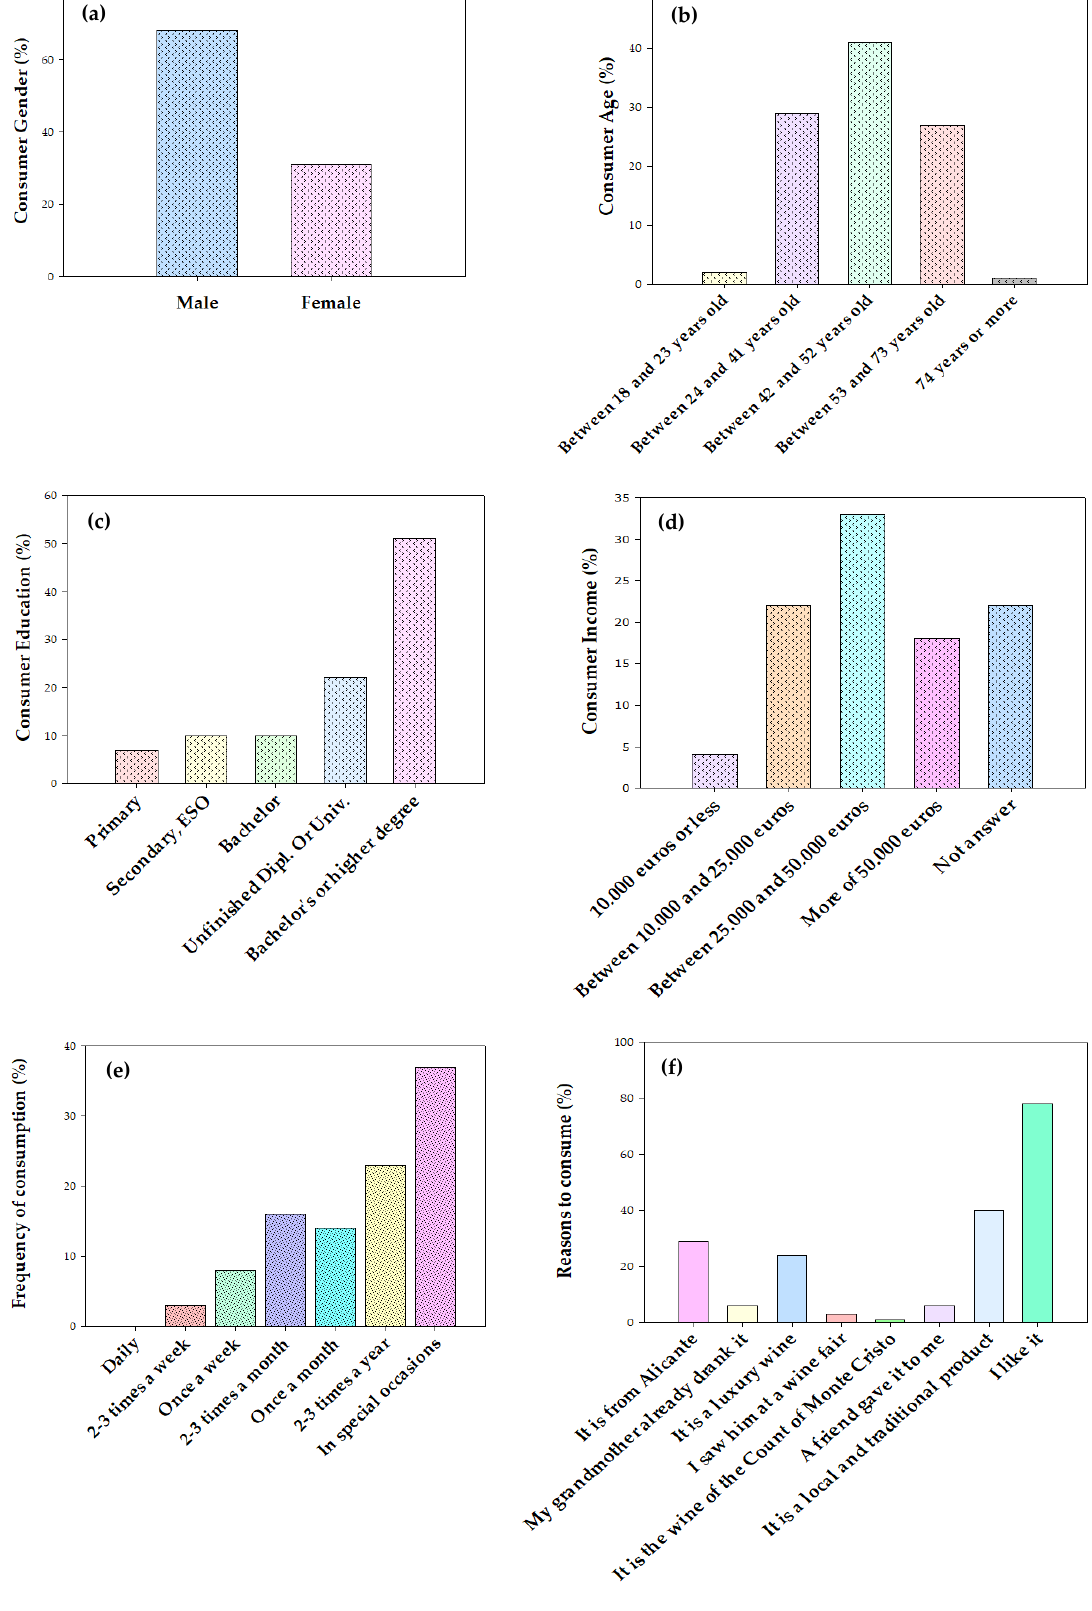
Figure 3. Fondill ó n consumer profile as affected by ( a ) gender, ( b ) age, ( c ) educational level, and ( d ) annual income, together with key consumption habits: ( e ) consumption frequency and ( f ) main reasons to buy and consume this